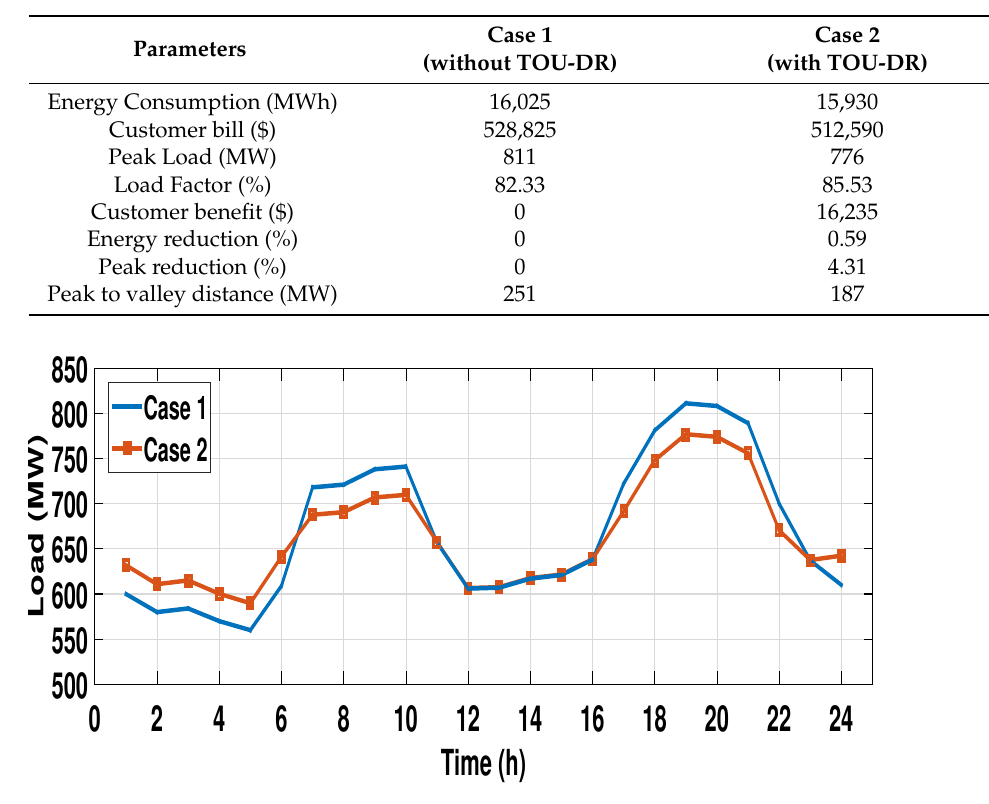
Table 5. Load profile characteristics and analysis.